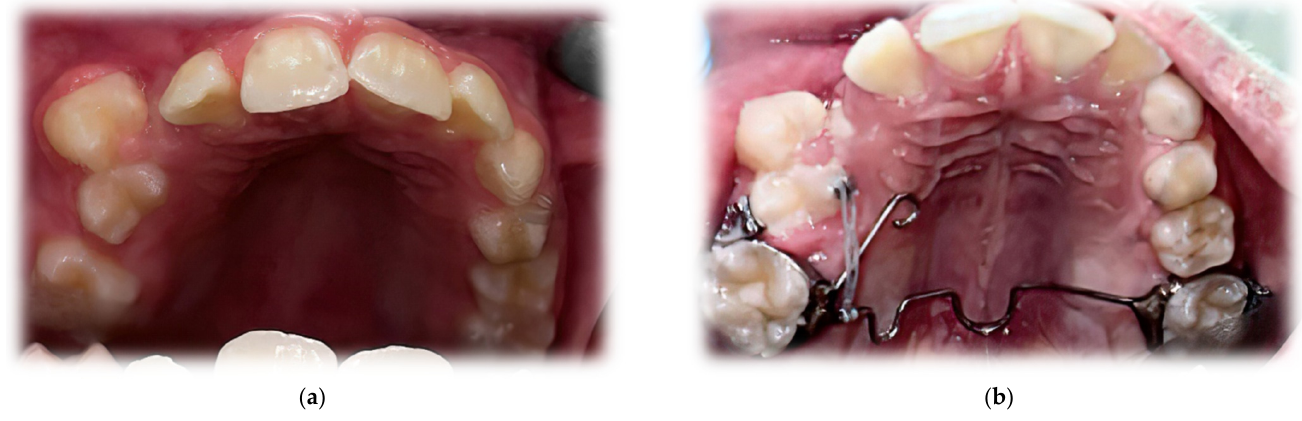
Figure 11. Comparison of three-dimensional CBCT reconstruction before surgery ( a ) and 6 months after surgery ( b ).